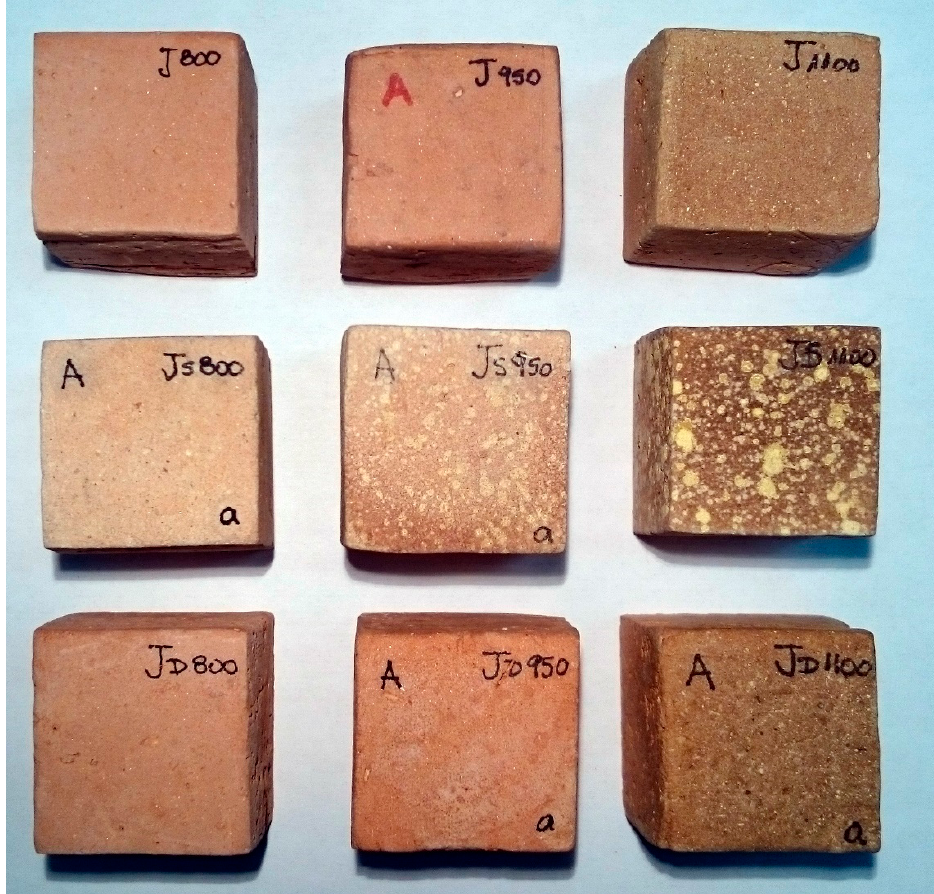
Figure 8. Appearance of fired bricks without additives (J) and with added sodium chloride (JS) and calcined diatomite sludge (JD) fired at 800, 950, and 1100 °C. Brick cubes have a 4 cm-edge.